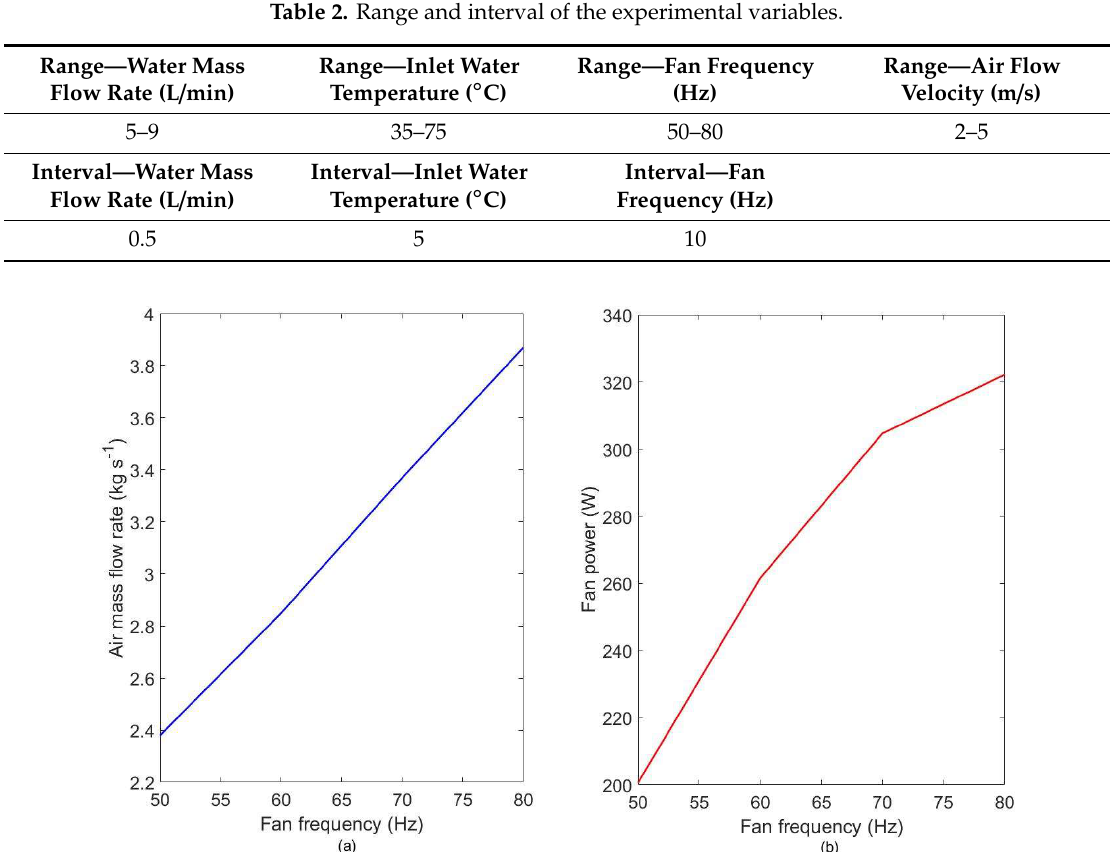
Figure 3. ( a ) Air mass flow rate depending on fan frequency; ( b ) fan power as a function of fan frequency. Table 2 . Range and interval of the experimental